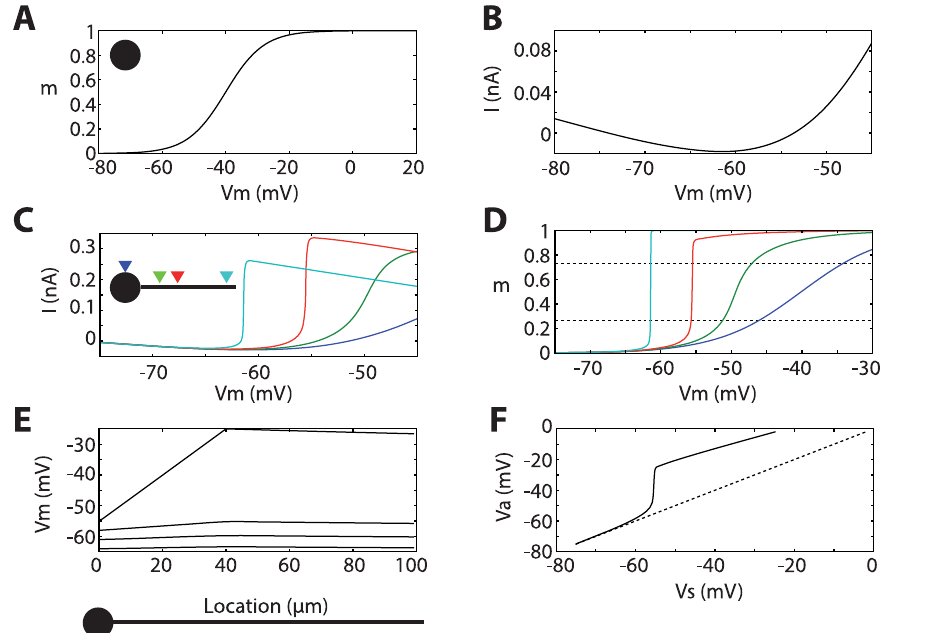
Figure 1. Sharpness of spike initiation with distal initiation (Na channels clustered at a single point). A, Proportion of open Na channels as a function of the voltage of an isopotential neuron. B, Current-voltage relationship in the isopotential neuron with Na and leak channels. C, Current-voltage relationship in a ball-and-stick model, with Na channels at the soma (dark blue), and at 20 m m (green), 40 m m (red) and 100 m m (light blue) away from the soma. D, Proportion of open Na channels as a function of somatic voltage of the ball-and-stick model (color code as in C). E, Voltage across the axon as the soma is depolarized by steps of 3 mV (4 values from 2 64 mV to 2 55 mV), with Na channels at 40 m m from the soma. F, Voltage at the initiation site as a function of somatic voltage, showing the loss of voltage control around 2 55 mV. voltage V s of 2 60, 2 55 and 2 50 mV. The value of V a is determined by the intersection of the red and black curves: 2 59, 2 52 and 2 40 mV. Thus V a is amplified compared to the somatic voltage but still varies continuously with it. When the initiation site is at 40 m m from the soma, corresponding to the red curves in Fig. 1C–D, a qualitatively different situation occurs, as shown in Fig. 2C. Compared to the previous case, the only difference is that the axial resistance R a is twice larger. But now as the somatic voltage is increased, the intersection point suddenly jumps from about 2 55 mV to 2 25 mV. This occurs because the number of solutions to the current equation changes from 3 to 1 when V s is increased, that is, a bifurcation occurs with respect to variable V s . It corresponds to the loss of voltage control seen in Fig. 1F. Graphically, this bifurcation occurs when the line representing the lateral current (black) is tangent to the curve representing the Na current (red) at the intersection point. This can only happen if the slope of the line (1/R a ) is smaller than the maximum slope of the Na curve. Thus there is a critical value of R a above which spike initiation becomes sharp. At this point, represented in Fig. 2D, the black line is tangent to the red curve at the inflexion point. This critical value can be calculated as a function of parameters (see Text S1, section 1). With the Na channel properties used in this model, the condition for sharpness is approximately: R a .g Na . 0.27, where R a is the axial resistance to the initiation site and g Na is the total maximal conductance of Na channels. The axial resistance is determined by the geometry of the AIS and by the intrinsic resistivity R i (150 V .cm in this model). The condition can then be written R i .g Na .x/d 2 . 0.21, where d is the axon diameter and x is the distance of the initiation site away from the soma. For the present model, the critical point occurs when the Na channels are placed at distance x=27 m m away from the soma (see Fig. 2D).